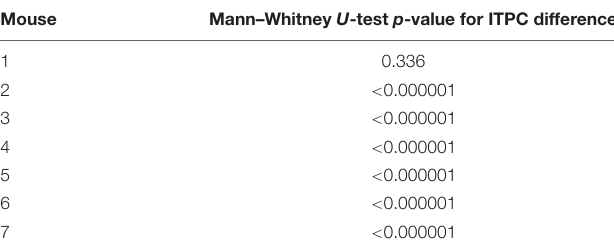
TABLE 2 | Individual mouse differences in evoked gamma coherence from isoflurane – propofol (all p -values are Bonferroni corrected unless otherwise